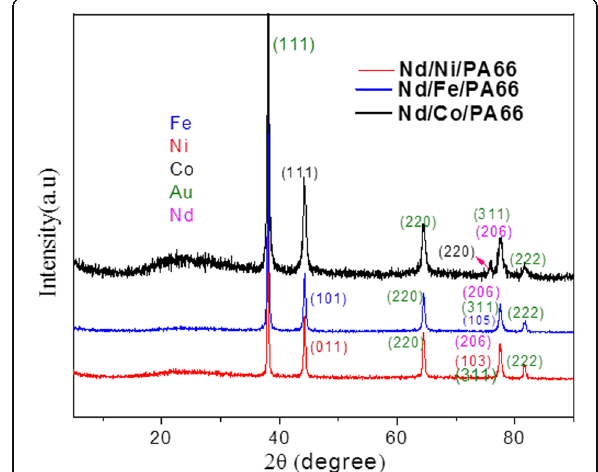
Fig. 3 SEM images: a Nd/Ni/PA66, c Nd/Co/PA66, e Nd/Fe/PA66; typical TEM images: b Nd/Ni/PA66, d Nd/Co/PA66, and f Nd/Fe/PA66